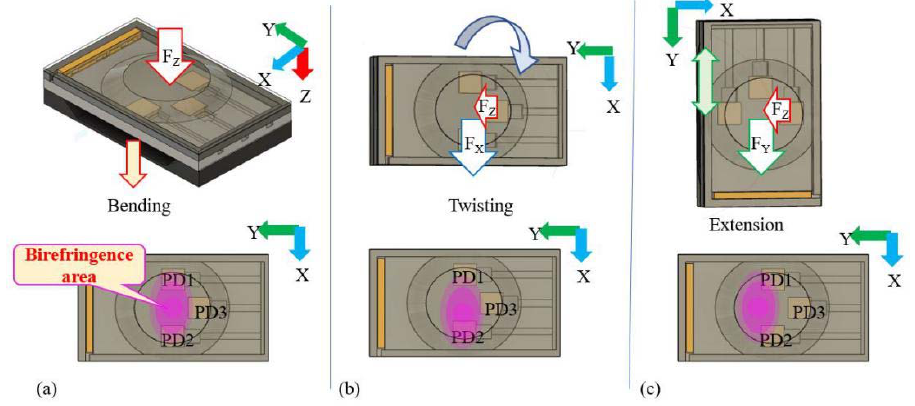
Figure 4. Schematic diagram of how the tactile sensor detects forces: ( a ) detection of normal force, ( b ) detection of F X , ( c ) detection of F Y .